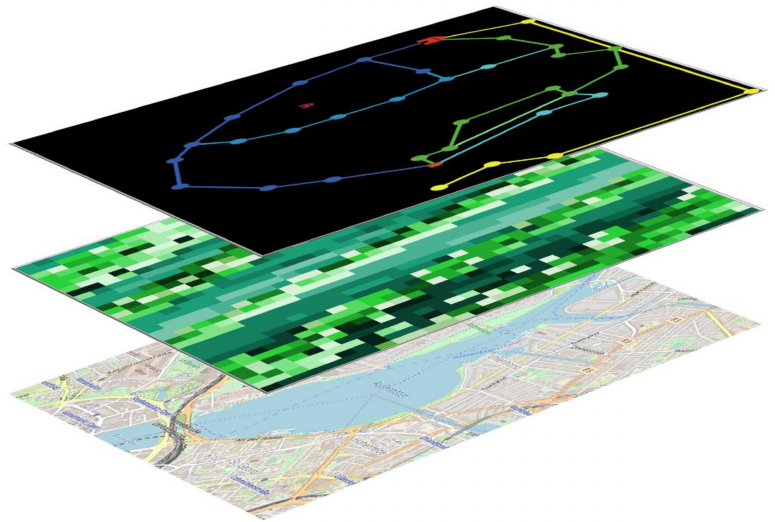
Figure 3. Three-level structure based on Figure 1, adapted to the model. The first layer below represents the selected research area of the Hamburg map with geographical information (including traffic); the second middle layer shows the environmental stressors (NO 2 is shown here); and the third layer presents the traffic network (roads, bike way, rails) and the agents (behavior,